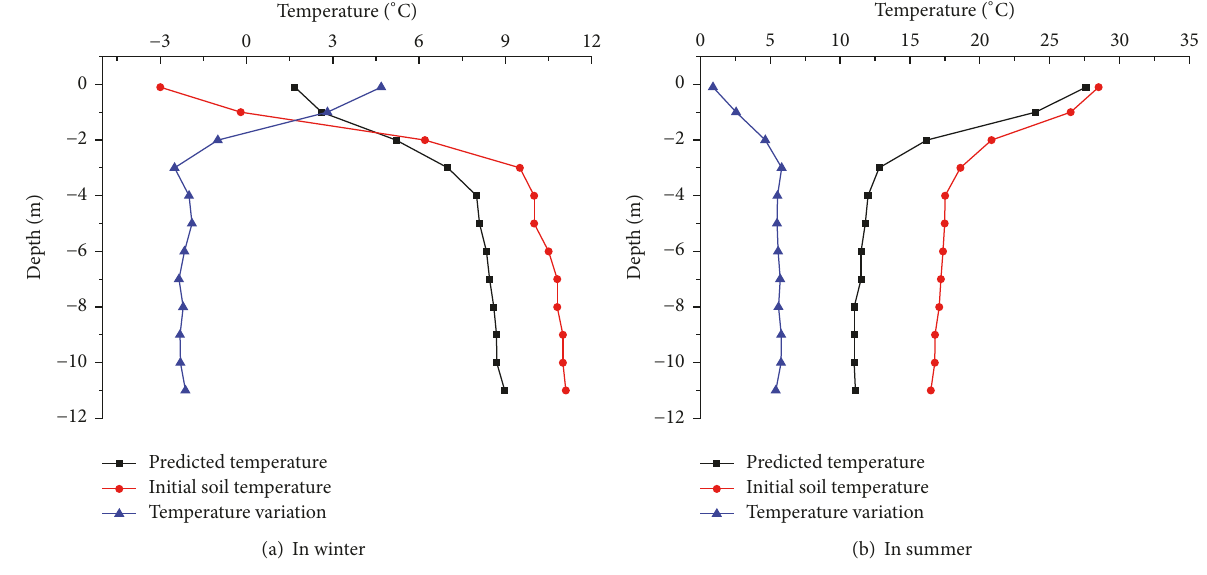
Figure 13: Predicted temperature and its variation on energy pile surface.